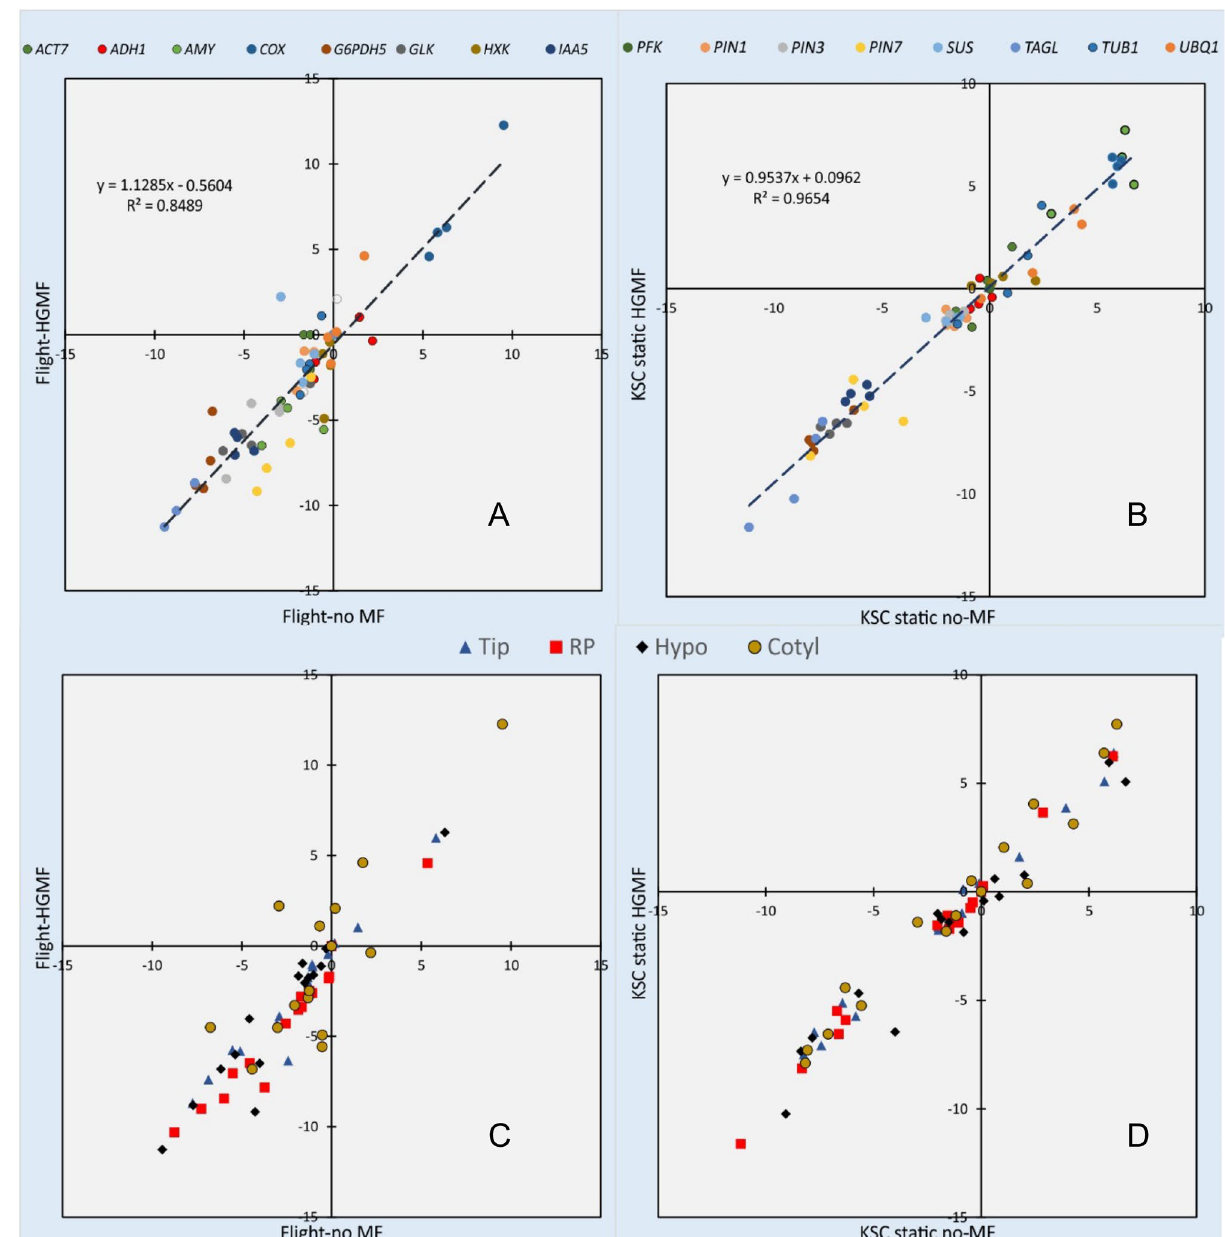
Figure 3. Transcription values between space grown Brassica rapa seedlings ( A , #1) and static ground controls ( B , #23) in the presence and absence of HGMFs show strong correlation (unity slope) and low scatter (R 2 = 0.85 and 0.95), indicating no or low effect of magnetic fields on transcription. Panels ( C ) and ( D ) identify the examined tissues in ( A ) and ( B ), respectively. The data sets use PFK as reference and show efficiency-corrected ΔC q and log(2) transformed